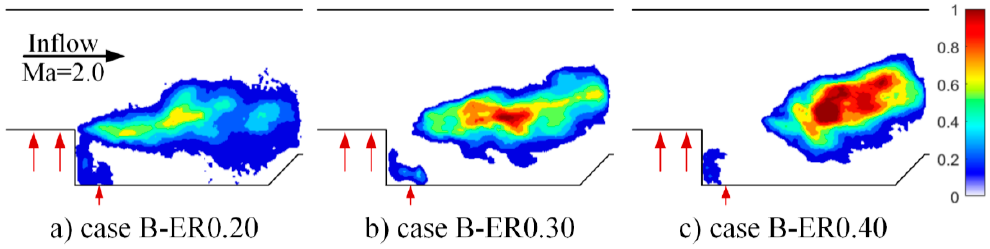
Figure 9. Representative CH* spontaneous emission images during the combustion process of cases with injection Scheme B.